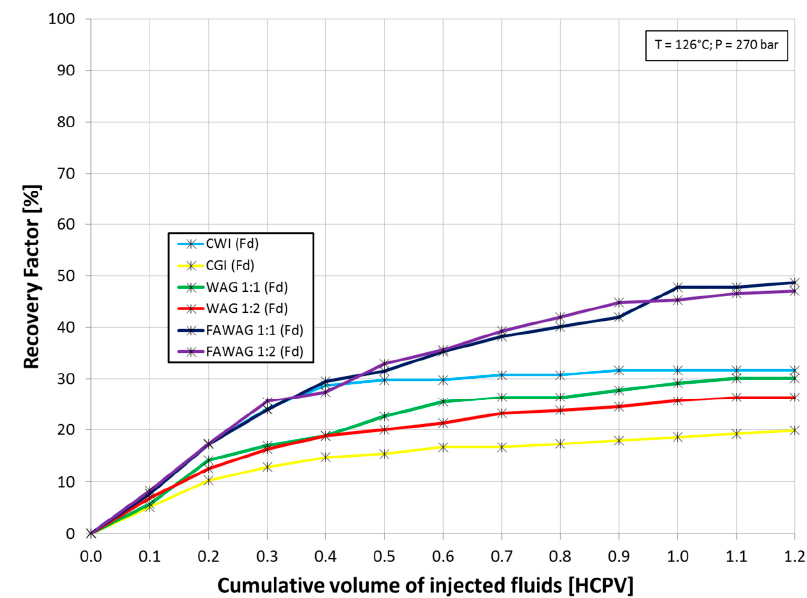
Figure 8. The efficiency of oil recovery using different methods of injection in fractured cores. Figure 8. The e ffi ciency of oil recovery using di ff erent methods of injection in fractured